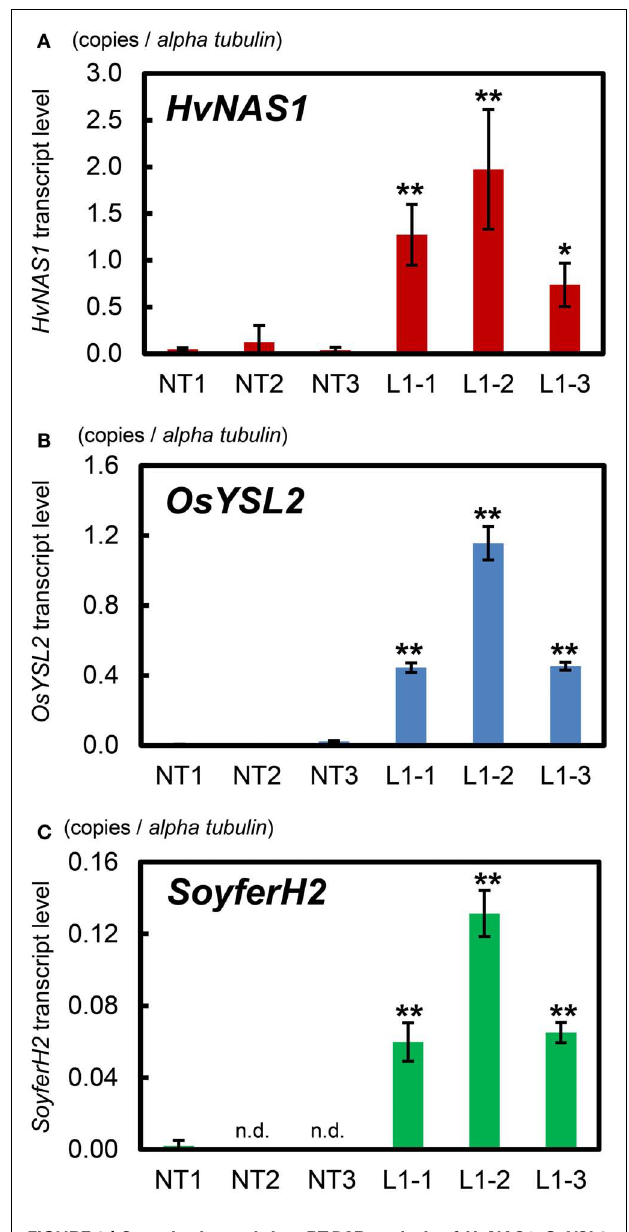
FIGURE 9 | Quantitative real-time RT-PCR analysis of HvNAS1 , OsYSL2 , and SoyferH2 . (A) HvNAS1 , (B) OsYSL2 , and (C) SoyferH2 expression levels.T 1 plants were cultivated in commercial soil (Bonsolichigou) in a greenhouse.Total RNA was extracted from immatureT 2 seeds (seeds at the early milky stage, 10days after fertilization) of each line ( n = 3). NT, non-transgenic Paw SanYin. L1-1, L1-2, and L1-3, Paw SanYin-Fer-NAS-YSL2 transgenic line 1 sublines. Bars represent means ± SE of three independent real-time RT-PCR reactions. Asterisks ( * ) and ( ** ) above the bars indicate significant differences at P < 0.05 and P < 0.01, respectively, between NT and L1 sublines (determined by t -test). n.d., not